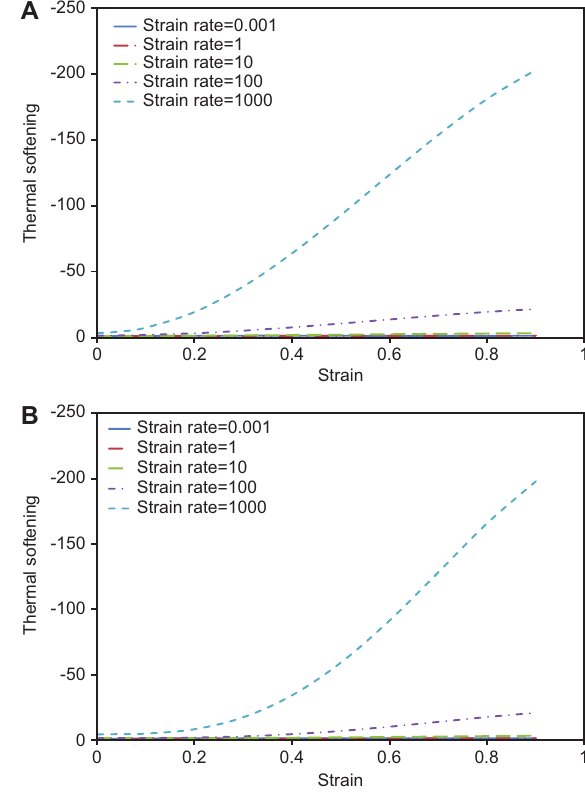
Figure 15 Change of thermal softening vs. strain of CR-1018 steel for different temperatures at strain rates of (A) 0.001/s and (B) 1000/s.